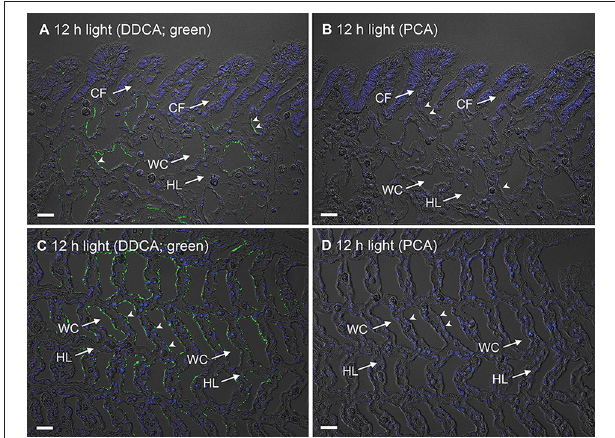
FIGURE 8 | A validation of the immunostaining of the Dual Domain Carbonic Anhydrase (DDCA) using a peptide competition assay (PCA). The immunofluorescence localization of DDCA in the ctenidial filaments (CFs) and tertiary water channels (WCs) of a ctenidium of Tridacna squamosa exposed to 12h of light using an anti-DDCA antibody (A,C) , or the same anti-DDCA antibody pre-incubated with the immunizing peptide in PCA (B,D) . The anti-DDCA immunofluorescence is shown in green, overlaid with DAPI nuclei staining and differential interference contrast images. Arrowheads in (A,C) indicate DDCA-immunostaining at the apical membrane of some epithelial cells at the base of CFs and WCs. By contrast, there is a lack of anti-DDCA antibody staining in the control with PCA (B,D) in both CFs and WCs. HL, hemolymph. Scale bar: 20 µ